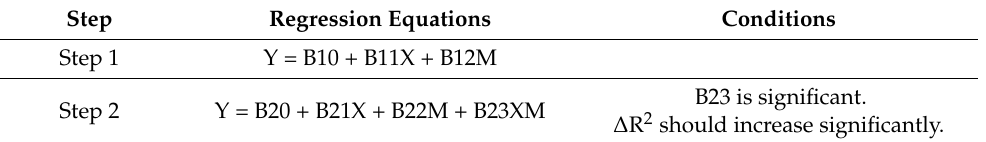
Table 1. Moderating effect analysis